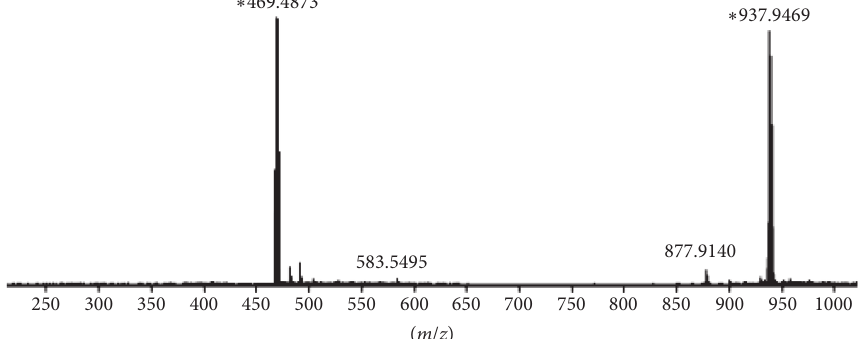
Figure 2: ESI-MS spectrum of the amine-oxide.